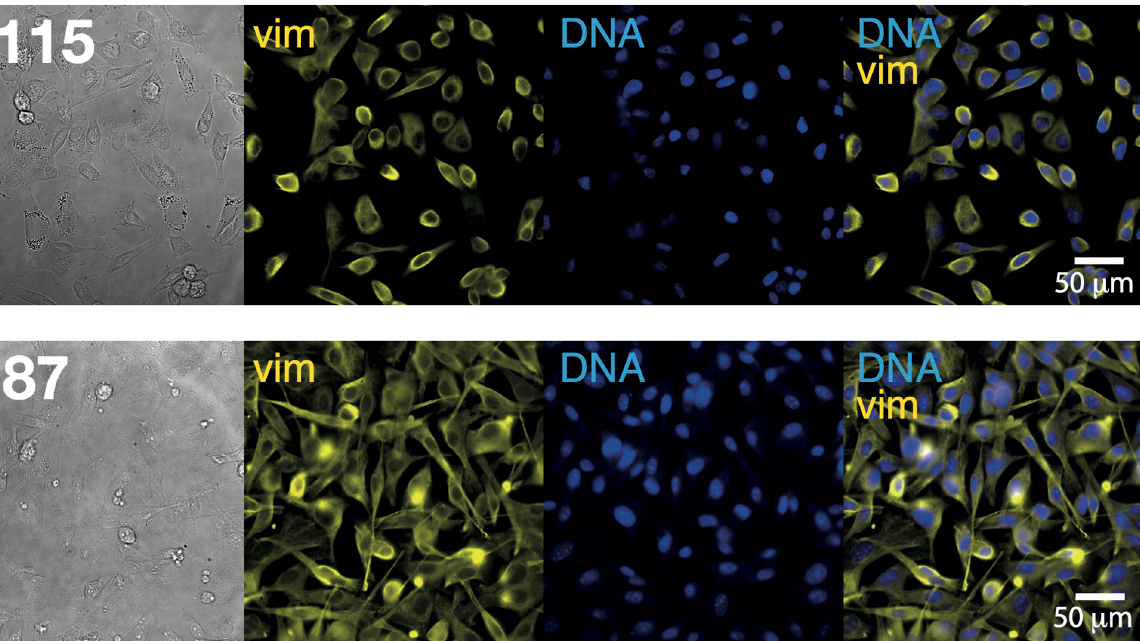
PLOS ONE | https://doi.org/10.1371/journal.pone.0281161 February 9,